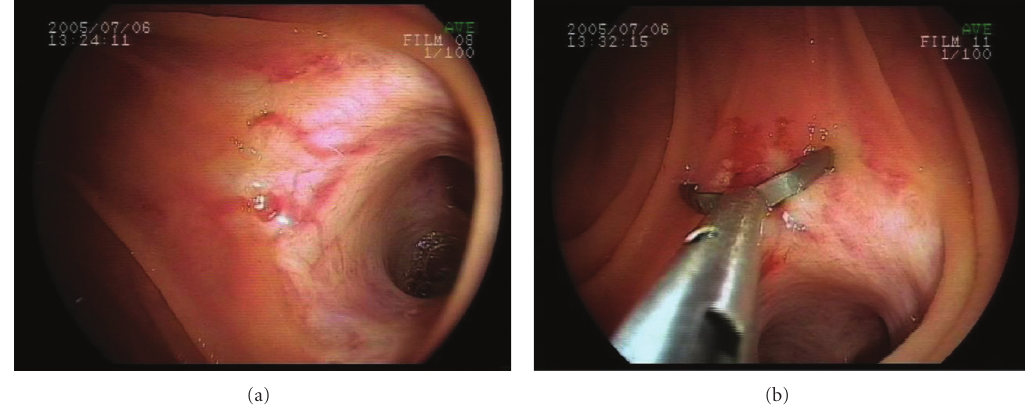
Figure 2: (a) Angioectasia was found at the choledochojejunostomy site. Bleeding was found after washing with water, and this site was determined to be the bleeding site. (b) Endoscopic clipping was performed.